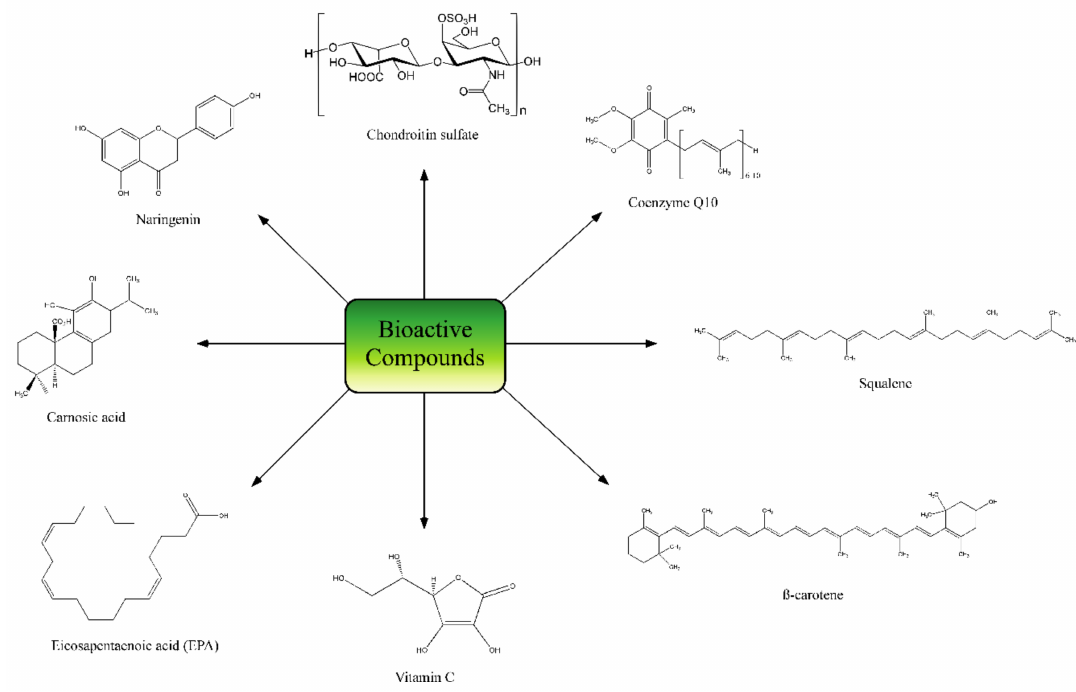
Figure 5. Representative structure compounds of different supplementation